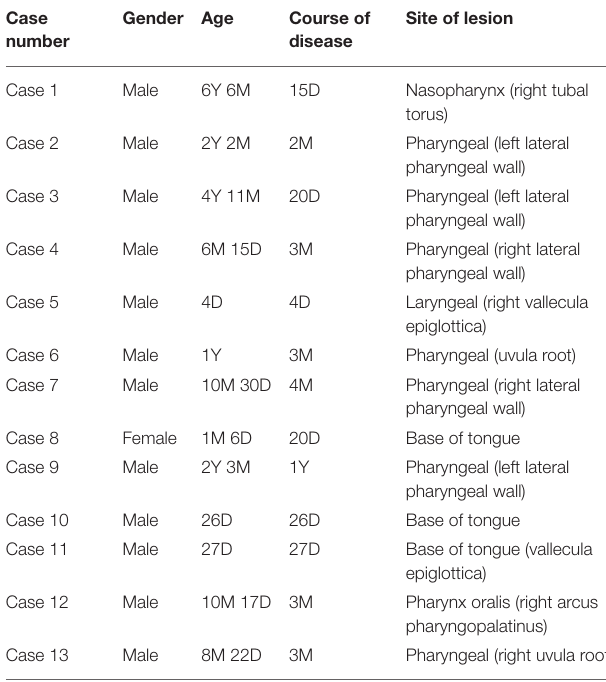
TABLE 1 | Clinical characteristics of 13